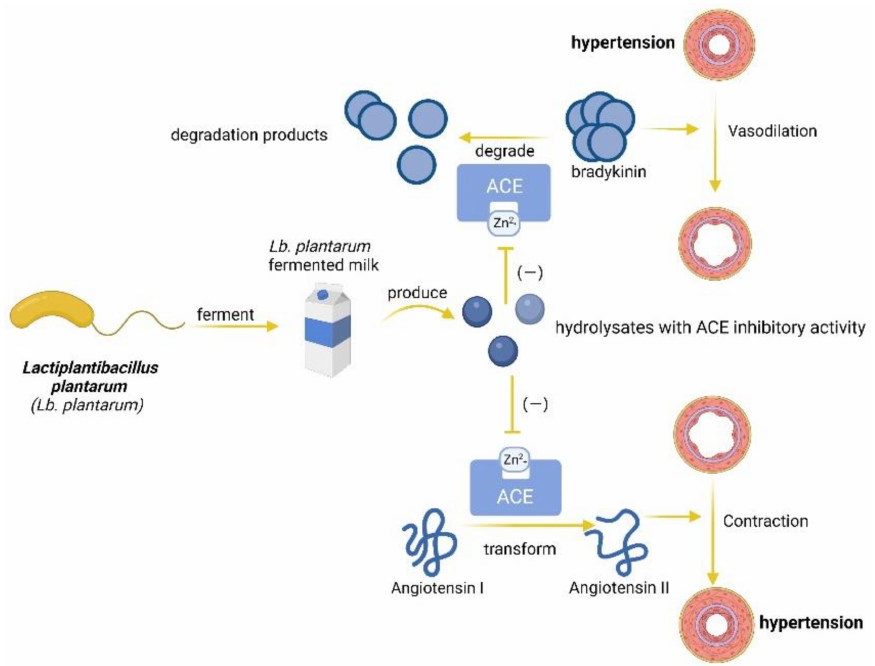
Figure 2. The blood pressure-lowering mechanism of Lactiplantibacillus plantarum fermented food. Lactiplantibacillus plantarum (Lb. plantarum) fermented foods can produce angiotensin- converting enzyme (ACE) inhibitors, which can prevent bradykinin from degrading and angiotensin I from transforming, thus relieving hypertension symptoms. (“ − “ means inhibition) (Created with